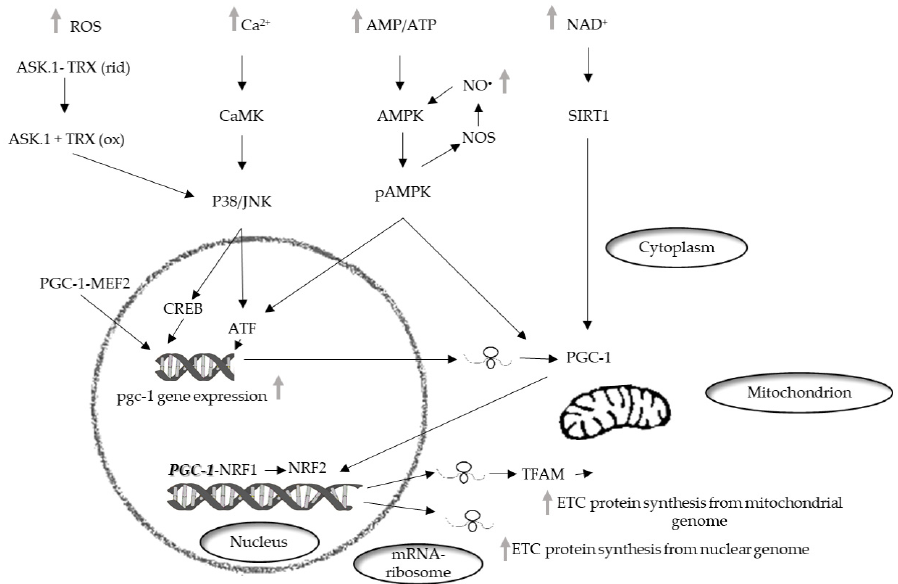
Figure 1. Schematic representation of the signaling pathways that mediate the mitochondrial biogenesis. PGC-1, peroxisome proliferator–activated receptor coactivator 1; NRF-1, nuclear respiratory factor 1; NRF-2, nuclear respiratory factor 2; MEF2, myocyte enhancer factor-2; cAMP, cyclic adenosine monophosphate; CREB, cAMP response element-binding protein; AMPK, AMP-activated protein kinase; PKA, protein kinase A; NO • , nitric oxide; NOS, nitric oxide synthase; CAMK, Ca 2 + / calmodulin-dependent protein kinase; p38, p38 mitogen-activated protein kinases; JNK, c-Jun N-terminal kinase; ASK-1, ETC, electron transport chain .